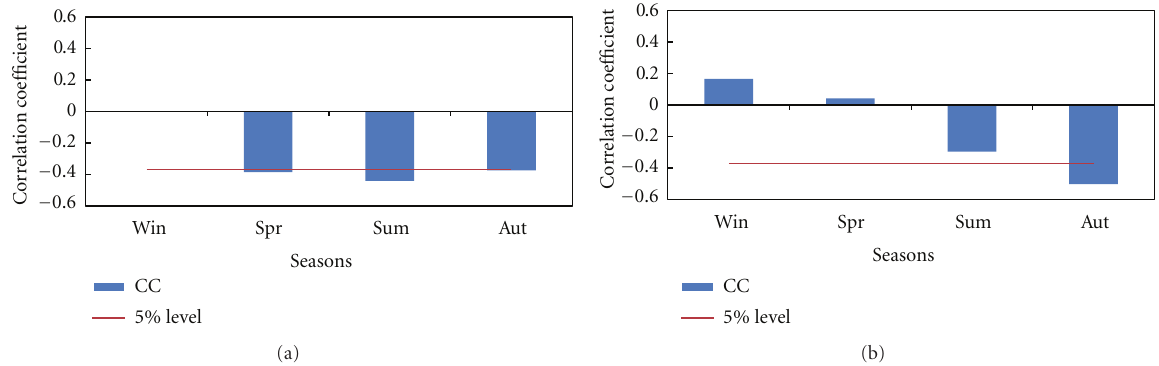
Figure 4: Relationship between seasonal mean Nino-3 SST anomaly and ISMR during (a) positive and (b) negative ESI